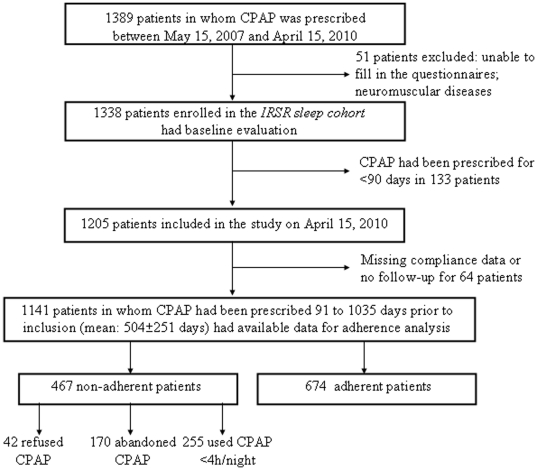
Flow diagram of subjects during the study.Abbreviations: CPAP: continuous positive airway pressure; IRSR, Institut de Recherche en Santé Respiratoire des Pays de la Loire.